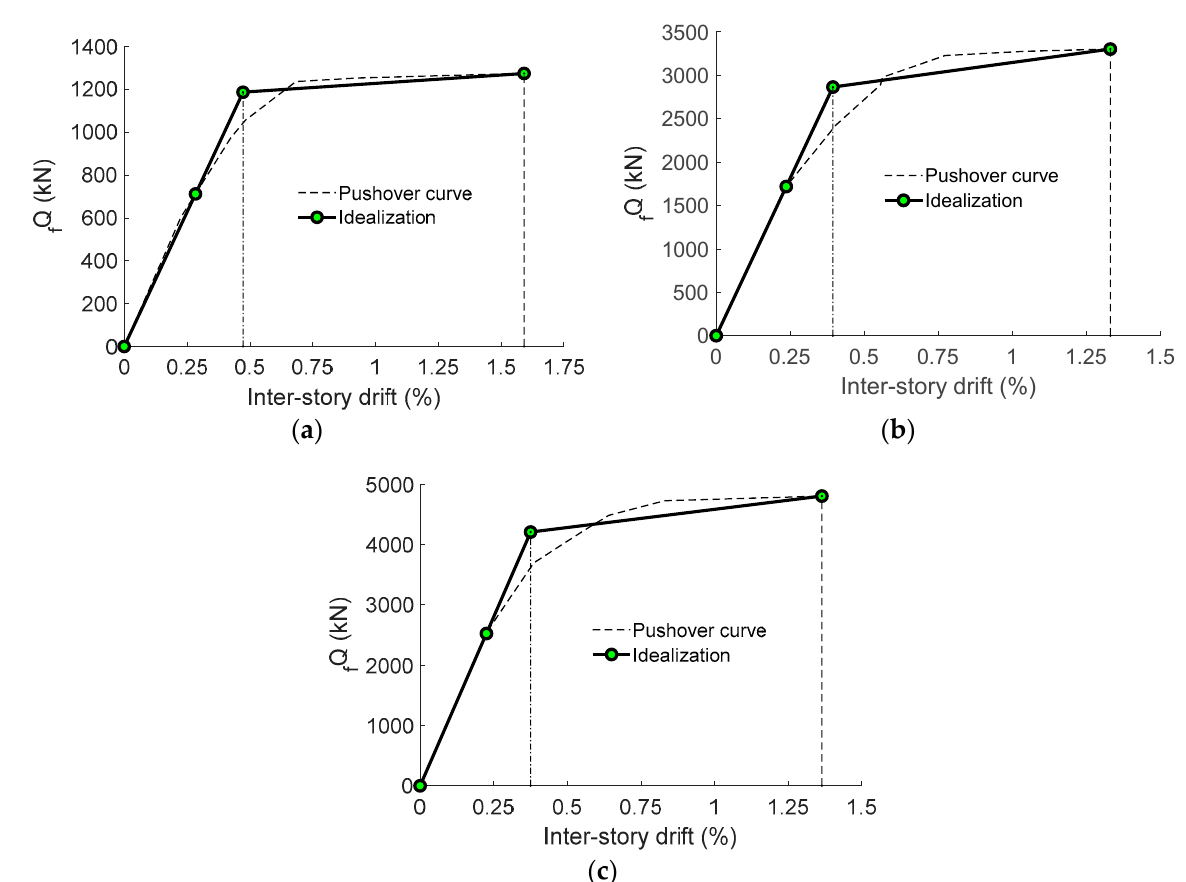
Figure 4. Shear force versus inter-story drift curve for the first story: ( a ) N3, ( b ) N6 and ( c ) N9.